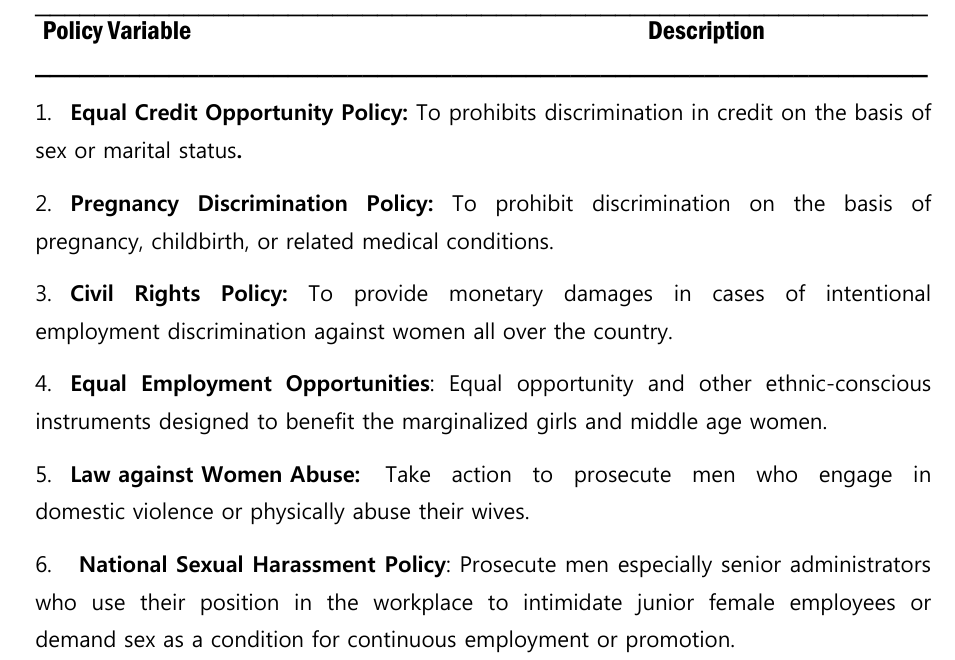
Table 10: Policies for Women’s